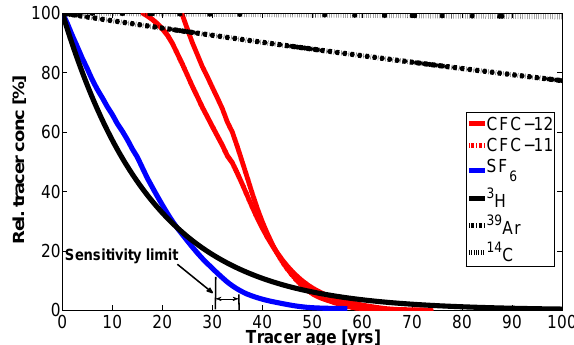
Figure 3. Tracer order based on the relation between the relative tracer concentration and the corresponding tracer age of 2012. SF 6 and 3 H as well as CFC-11 and CFC-12 show a similar behavior and cannot be used as tracer couples to constrain the IG-TTD. The sensitivity limit is explained in Sect.